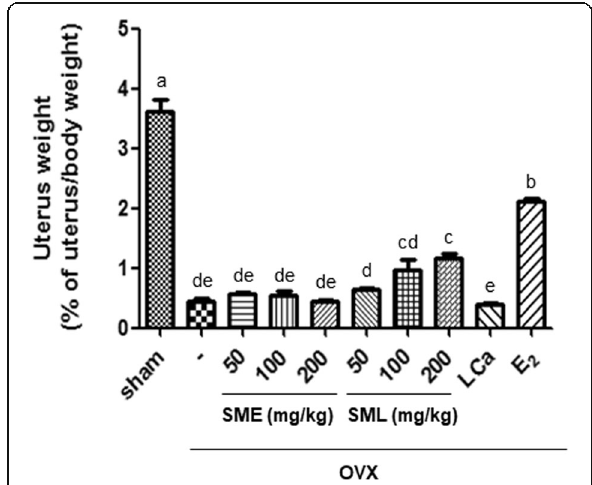
Fig. 1 Effects of SML on body weight and uterus weight in OVX mice. The uterus weights were collected at the conclusion of the study. Values are given as mean ± S.E.M. of three independent experiments ( n = 7) for all groups. Means unlike letters in a column with differ significantly ( p <